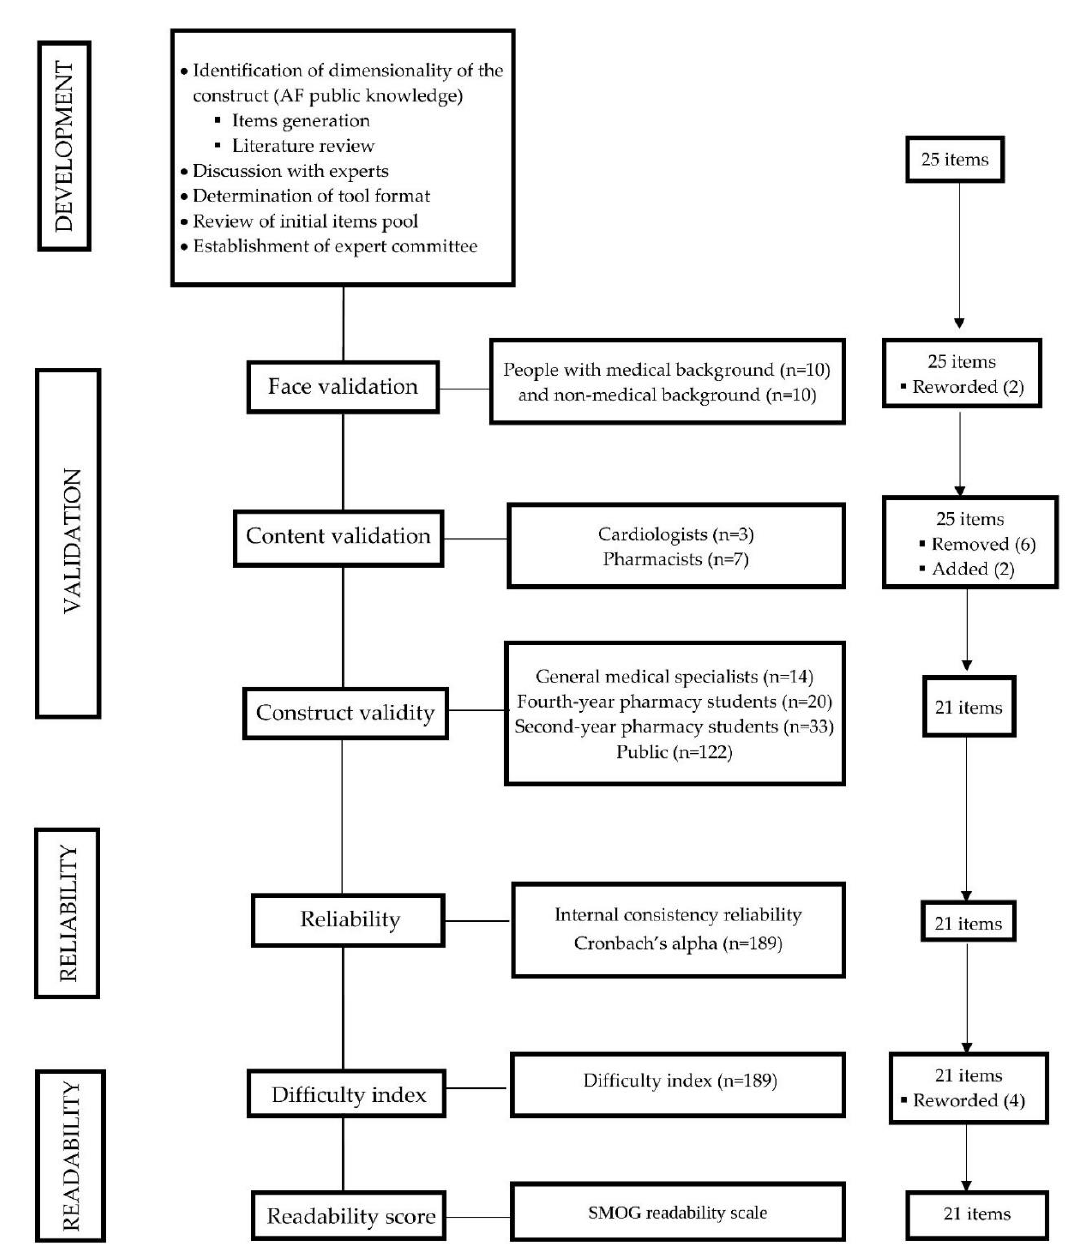
Figure 1. An outline of the development and validation process of the atrial fibrillation knowledge assessment tool (AFKAT). SMOG: Simplified Measure of